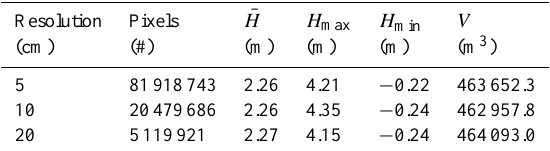
Table 2. Snow volume calculation using UAS measurements and three different spatial resolutions: 5, 10,